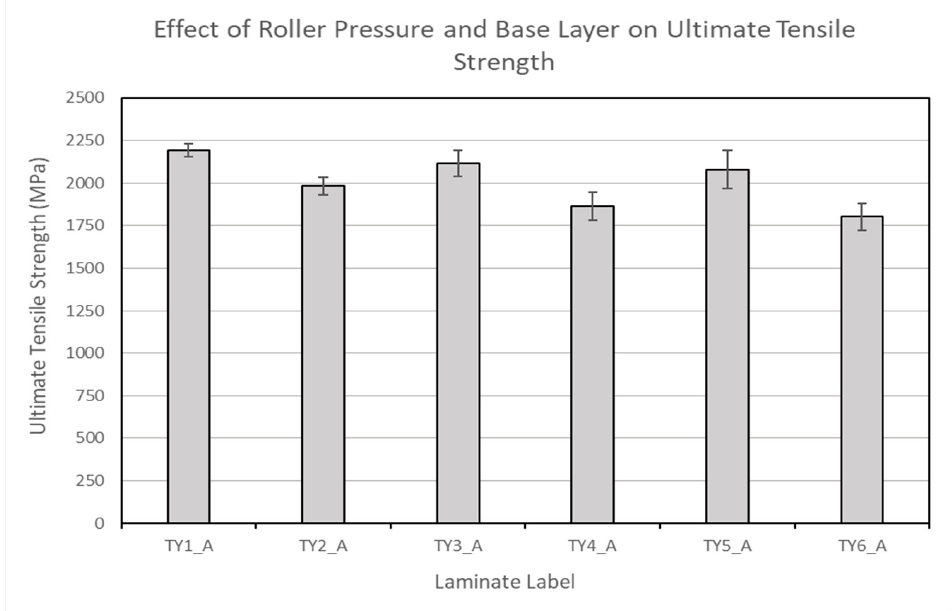
Figure 15. Effect of roller pressure and base layer on ultimate tensile strength for all laminates